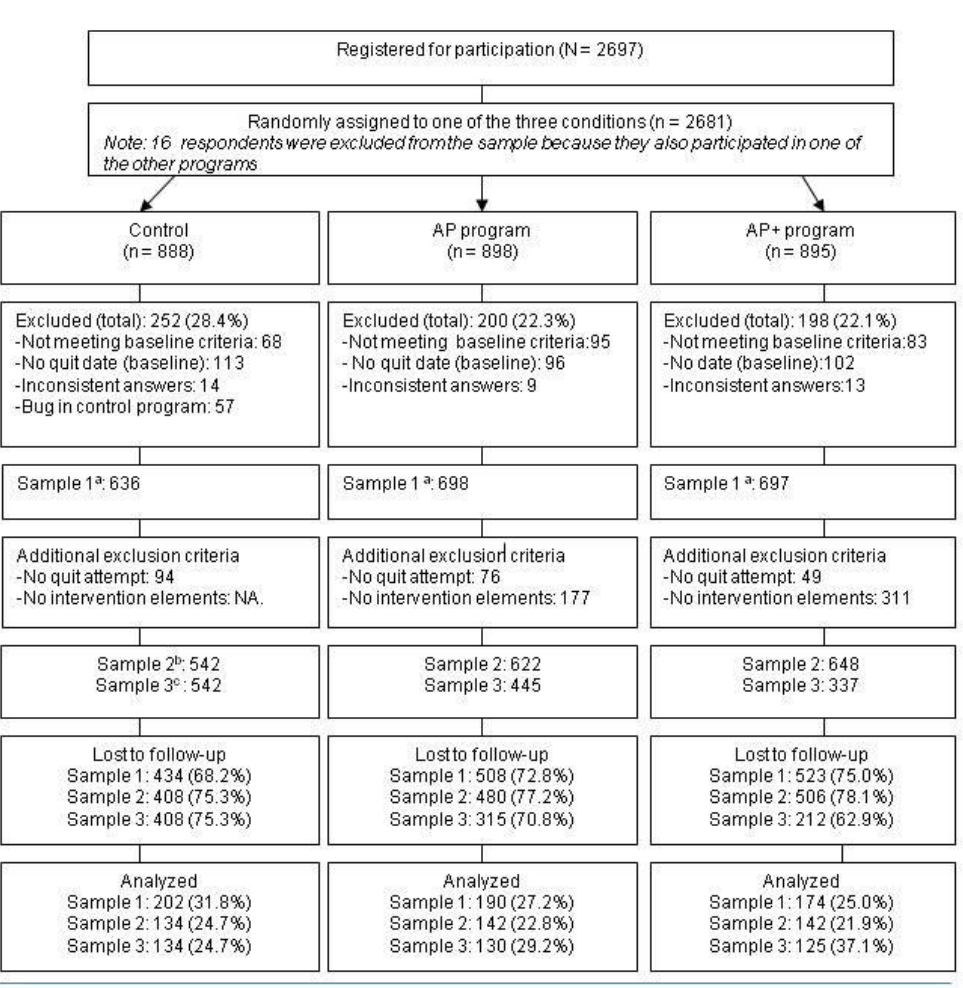
Figure 1. Enrollment and inclusion of respondents. NA = not applicable. a All respondents as randomly assigned, b modified sample excluding respondents who indicated after their quit date as well as at follow-up that they did not make a quit attempt during the study and respondents who quit too close to follow-up (see Analyses section in the Methods), c minimum dose sample additionally excluding respondents who did not adhere to at least one intervention